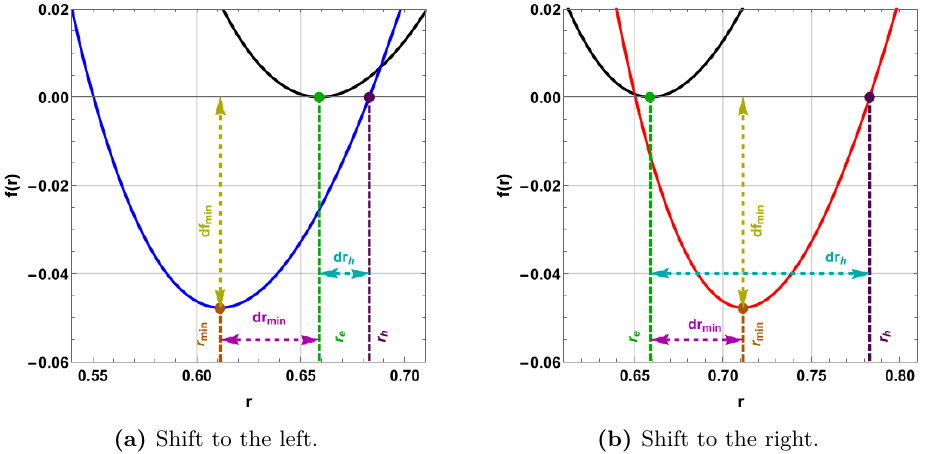
Figure 8. Variation of f ( r ) function after the particle absorption in the two situations: when the minimum point is shifted to the left and when it is shifted to the